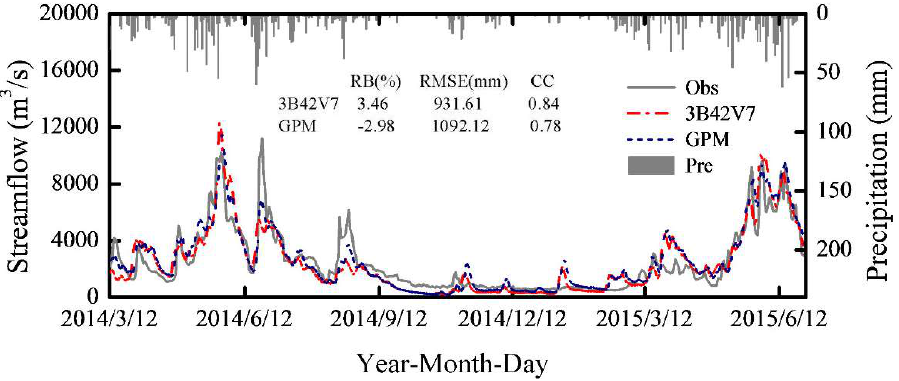
Figure 9. Comparison of the observed and simulated streamflow based on the 3B42V7 and GPM precipitation data by using VIC hydrological model in the Ganjiang River basin.